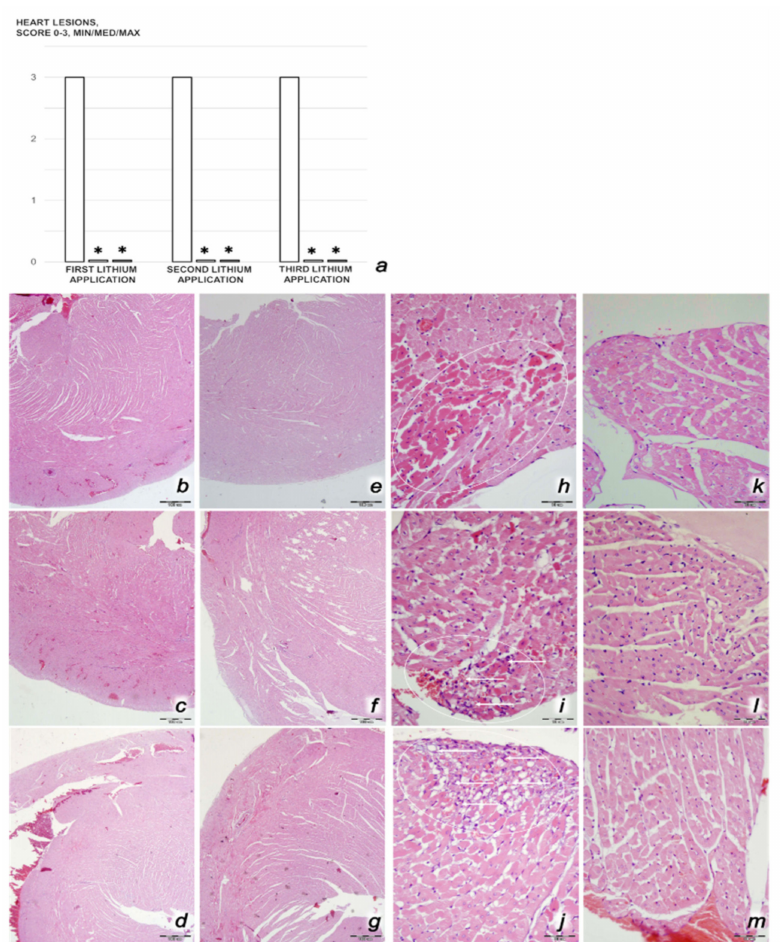
Figure 4. Heart pathology. ( a ) Microscopy scoring of the congestion lesions of the heart (scored 0–3) Min/Med/Max, ( a ) in the rats treated with lithium sulphate (500 mg/kg/day intraperitoneally for 3 days) that received medication (BPC 157 10 µ g/kg (light gray bars), 10 ng/kg (dark gray bars); saline 5 mL/kg (white bars)) given intraperitoneally. Six rats/group/interval. * p < 0.05, at least, vs. control. Heart histology in control lithium-treated rats ( b – d , h – j ) and BPC 157 lithium-treated rats ( e – g , k – m ); first lithium application ( b , e , h , k ); second lithium application ( c , f , i , l ); third lithium application ( d , g , j , m )). A marked congestion was found in control lithium-treated rats after each of the lithium administrations. Contrarily, lithium-treated rats that received BPC 157 regimens presented normal heart presentation of minimal heart congestion. Control lithium-treated rats pre- sented subendocardial marked ischemic myocytes (circles) after each of the lithium administrations, with degeneration and infiltration of neutrophils, particularly after the second and third lithium administrations (arrows). Contrarily, lithium-treated rats that received BPC 157 regimens presented normal myocardium (HE; magnification × 100, scale bar 100 µ m ( b – g ); magnification × 400, scale bar 10 µ m ( h – m